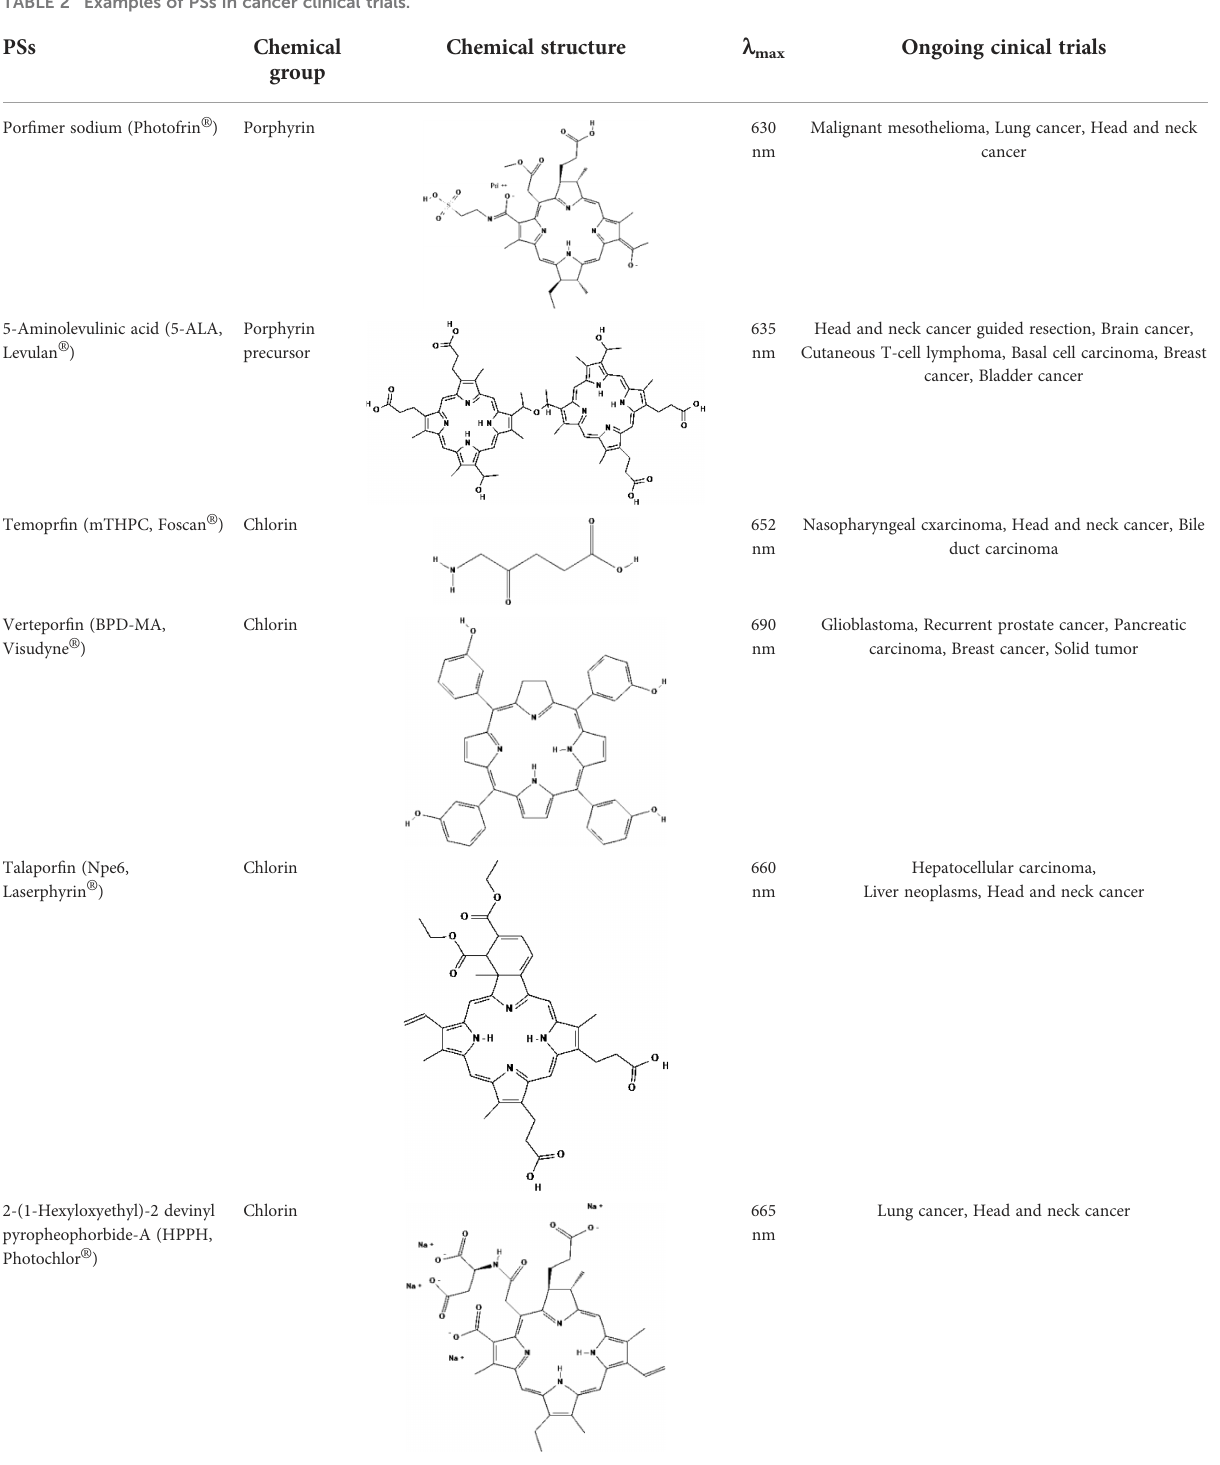
TABLE 2 Examples of PSs in cancer clinical